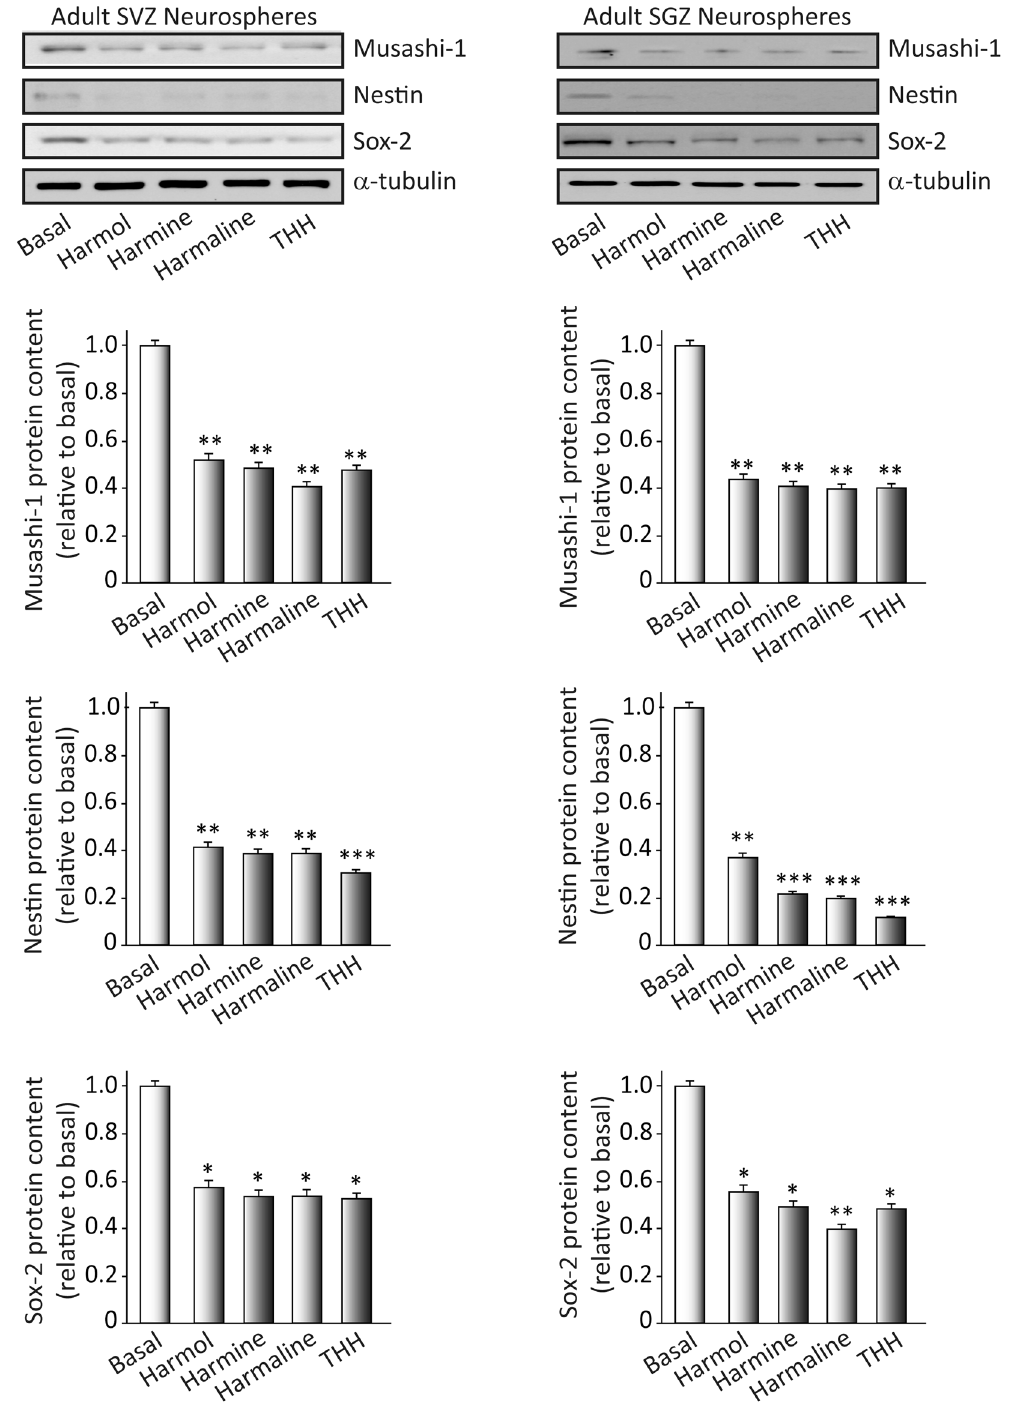
Figure 1. Effects of ayahuasca β -carboline alkaloids on stemness of cultured adult neurospheres. Representative Western blots and bar graphs showing expression levels of the precursor cell markers musashi-1, nestin and SOX-2 after treatment with each of the four alkaloids tested (1 µ M). Values in bar graphs indicate mean ± SD of the quantification of at least three independent experiments corresponding to four different cellular pools. The left side of the image shows results for the subventricular zone (SVZ) of the brain. The right side of the image shows results for the subgranular zone of the hippocampus (SGZ). * p ≤ 0.05; ** P ≤ 0.01; *** p ≤ 0.001 indicate significant results in the post-hoc pair-wise comparisons (Bonferroni) versus non-treated (basal)